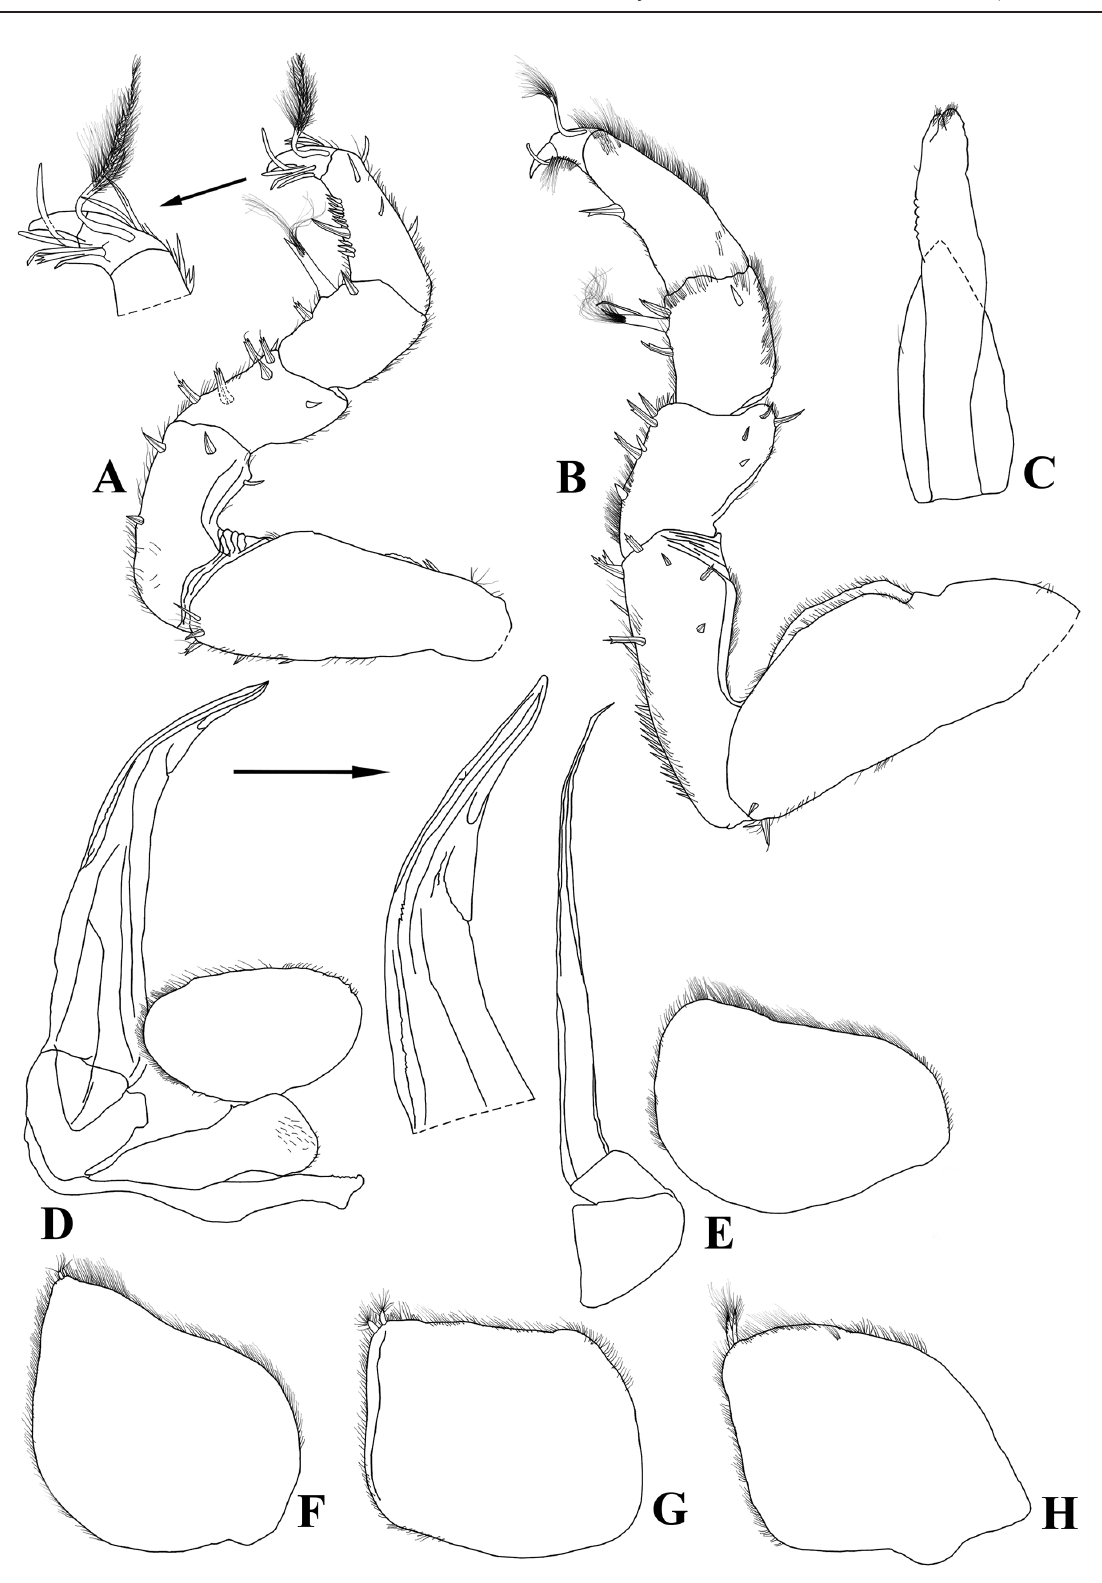
Fig. 12. Armadilloniscus luisi Carpio-Díaz, Taiti & Campos-Filho sp. nov., paratype, ♂ (CDUC- CRU 194). A . Pereopod 1. B . Pereopod 7. C . Genital papilla. D . Pleopod 1. E . Pleopod 2. F . Pleopod 3 exopod. G . Pleopod 4 exopod. H . Pleopod 5